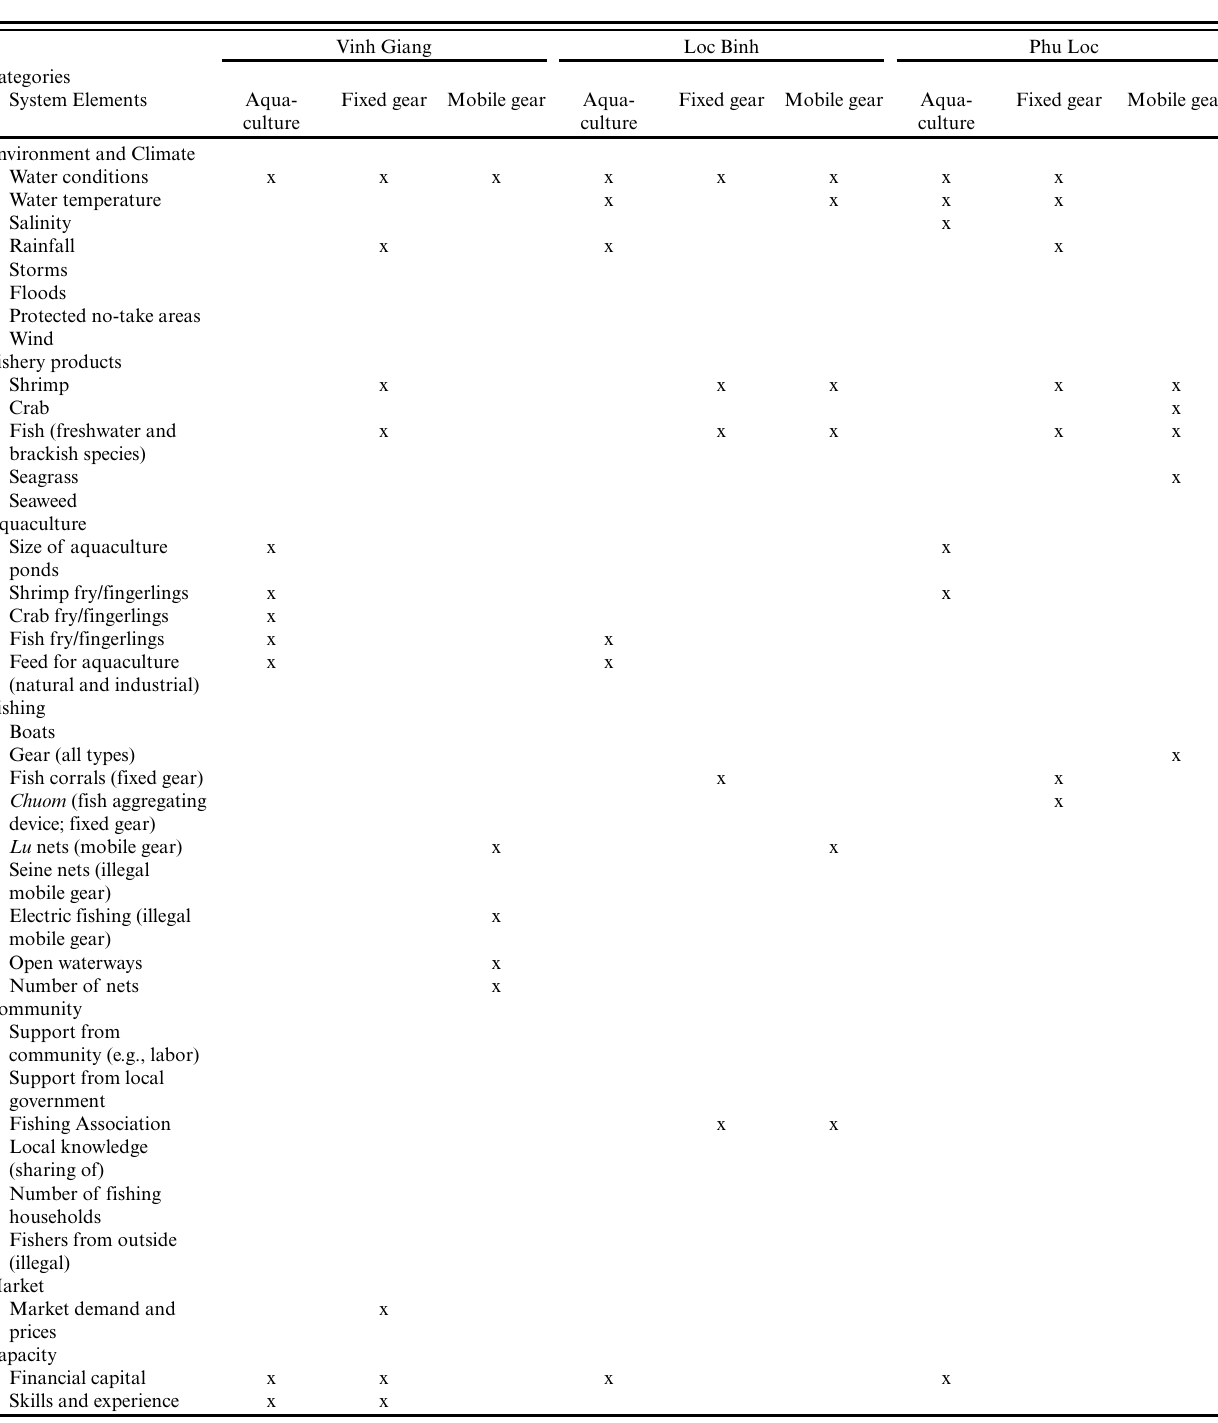
Table 4 . Key social-ecological system (SES) elements identified in focus groups. All elements identified during focus groups are listed; elements identified as most important are indicated with an